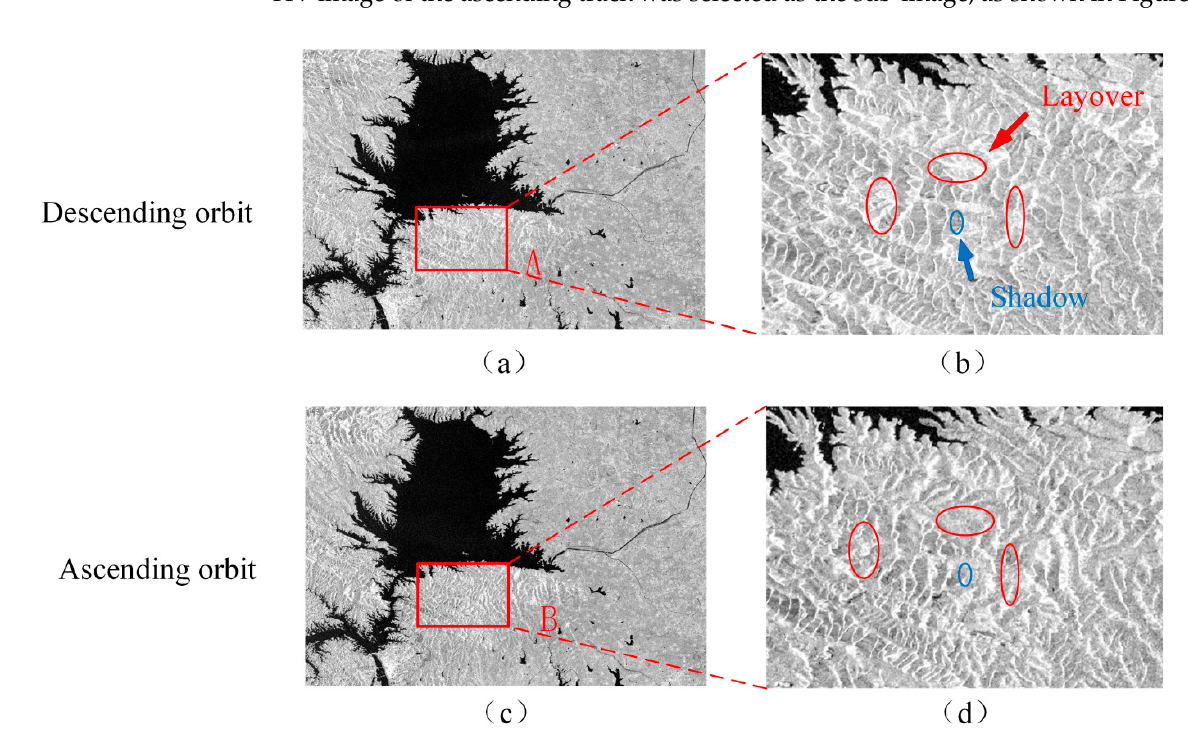
Figure 10. Gaofen-3 images of ascending and descending orbits:( a ) descending orbit HV polarized SAR image as primary image; ( b ) enlarged area in ( a ); ( c ) ascending orbit HV polarized SAR image as secondary image; ( d ) enlarged area in ( c ). Region A and B are the selected regions for subsequent quantitative analysis.